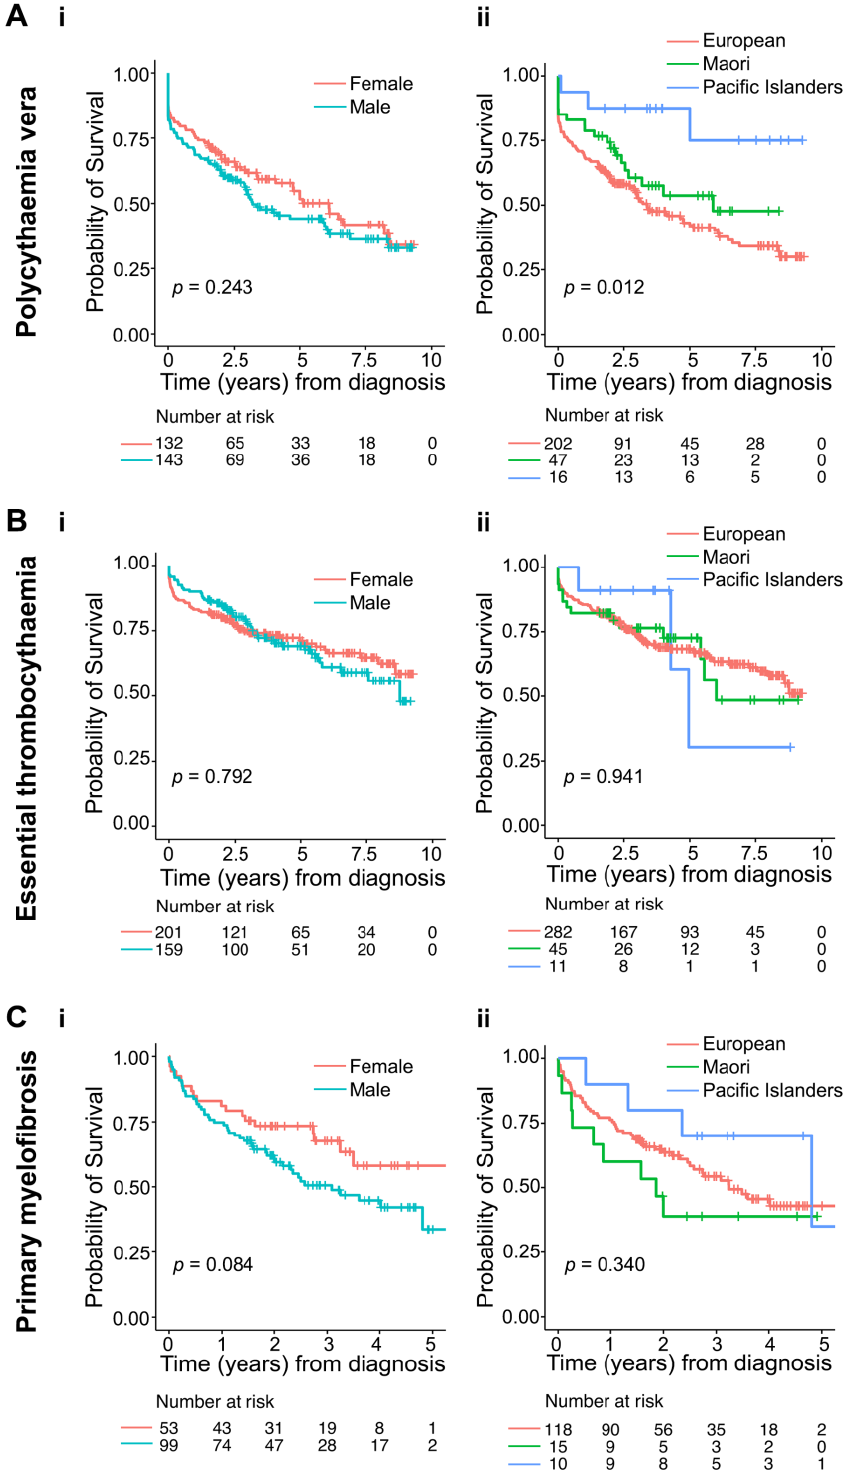
Figure 3. Influence of gender and ethnicity on survival of patients with myeloproliferative neo- plasms. Kaplan – Meier survival curves for patients with ( A ) polycythaemia vera, ( B ) essential thrombocythaemia, and ( C ) primary myelofibrosis reported to the New Zealand Cancer Registry during 2010 – 2017, stratified by gender ( i ) and ethnicity ( ii ). Log-rank p values are shown. Both Māori and Pacific Island patients died at significantly younger age s than Eu- ropeans (68.9, 66.1 and 81.0 years, respectively; p = 0.001; Table 1). After adjusting for age, gender and ethnicity, increasing age and male gender were identified as independent risk factors for mortality in PV. Mortality risk increased 7% with each year of age (HR: 1.07, 95% CI: 1.05 – 1.1%; p = 0.001; Table 2). Males had a 43% higher risk of dying than females (HR: 1.43 95% CI: 1.01 – 2.00; p = 0.04; Table 2).